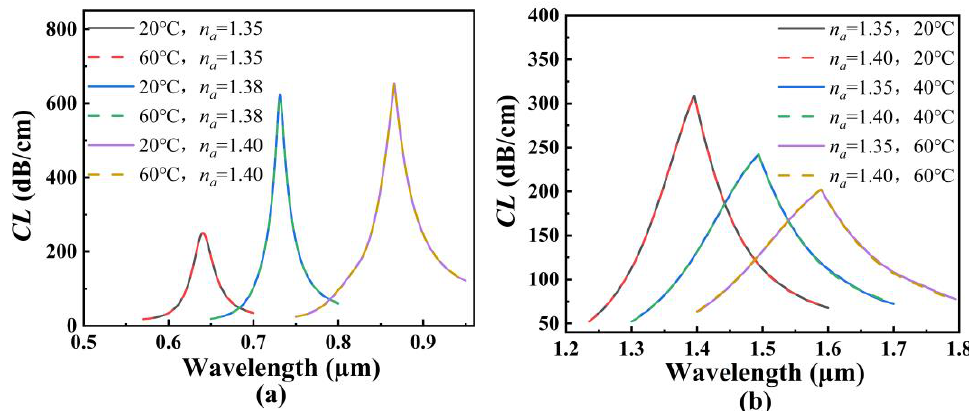
Figure 13. ( a ) The CL spectra of the core mode A when the analyte RI is chosen as 1.35, 1.38, and 1.40, and when the temperature is changed from 20 to 60 ◦ C. ( b ) The CL spectra of the core mode B when the temperature is chosen as 20, 40, and 60 ◦ C, and when the analyte RI is changed from 1.35 to